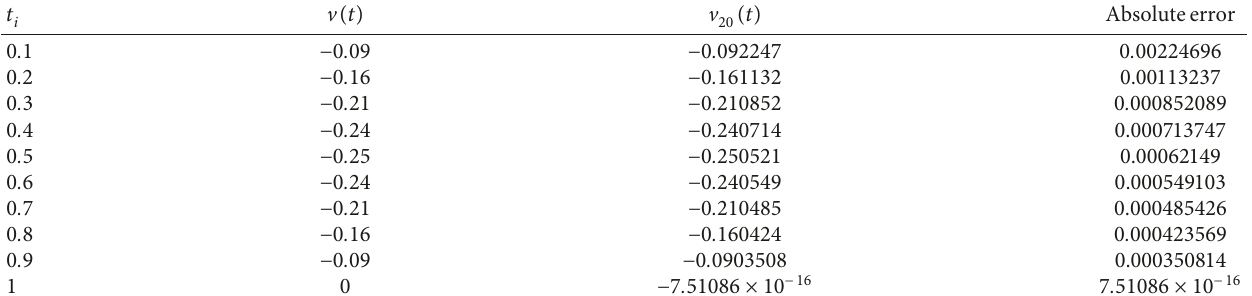
Table 2: The absolute error for Example 2 with n � 20.